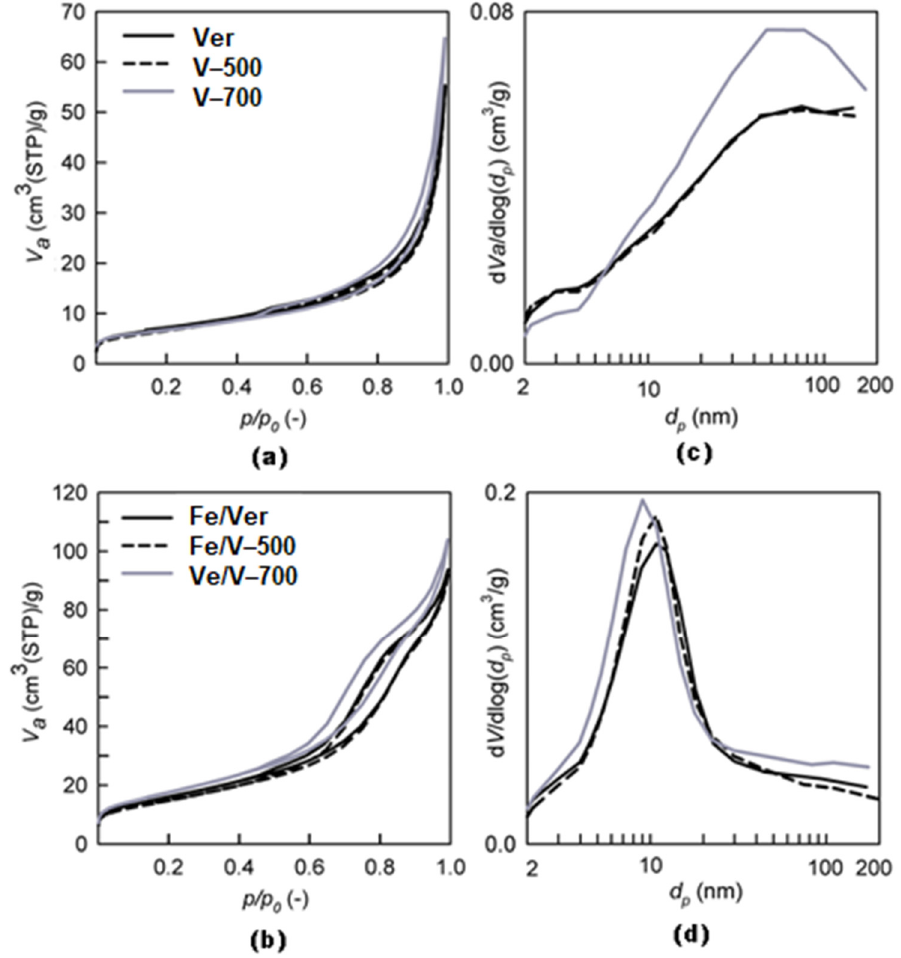
Figure 4. Nitrogen adsorption–desorption isotherms of: ( a ) Ver, V–500 and V–700 and ( b ) Fe/Ver, FeV–500 and Fe/V–700 and pore size distributions of: ( c ) Ver, V–500 and V–700 and ( d ) Fe/Ver, Fe/V–500 and Fe/V–700.